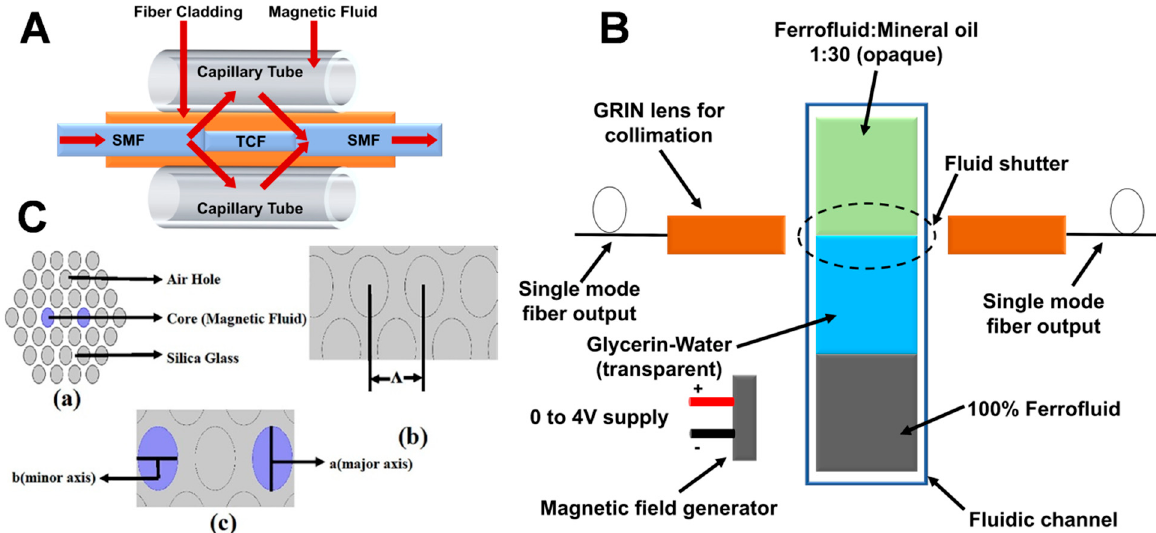
Figure 6. ( A ) A novel magnetic sensor employing a thin − core fiber (TCF) interferometer enclosed by ION − based FNs: standard modal interferometer; ( B ) schematic layout of ION FN − based optical fiber magnetic field sensor; ( C ) cross − sectional view of the novel magnetic field sensor using air holes and a silica cladding with Fe 3 O 4 NP − based FNs. Reprinted with permission from Ref.[77].